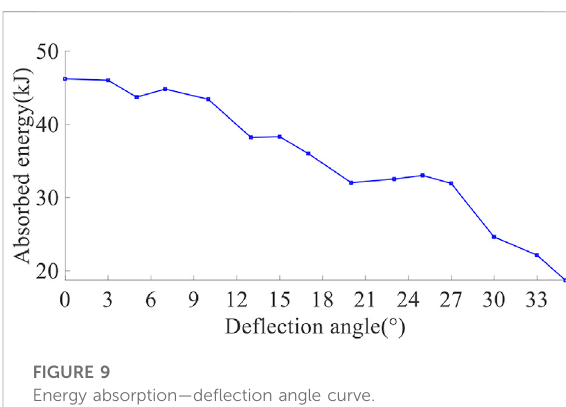
FIGURE 9 Energy absorption — de fl ection angle